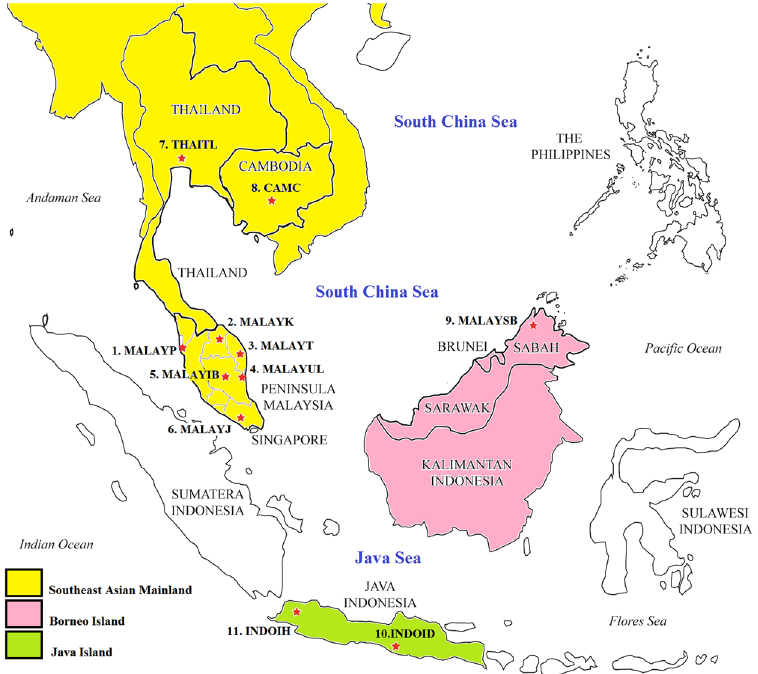
Figure 1. An outline map of Southeast Asia depicting sampling sites of Haematobia exigua used in this study. The map was created with QGIS software 2.18.3 (http://www.qgis.org/pl/site/) and modified by VLL with help from Z. Mustafa using Adobe Photoshop